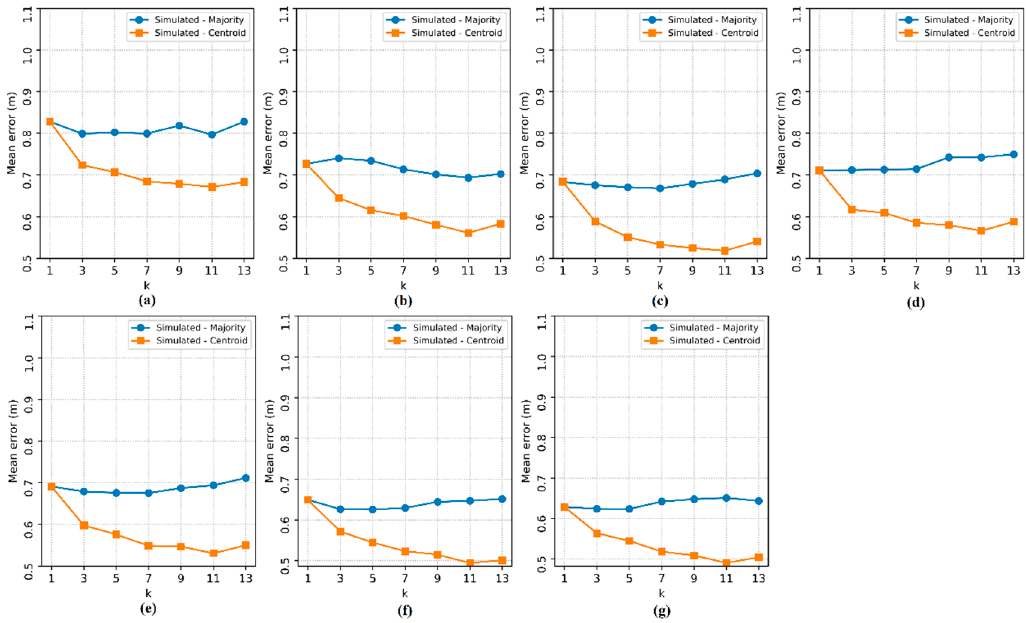
Figure 11. Localization mean error in the simulated environment with an area of 7 m × 7 m. The subfigures show the tests for each number of access points: ( a ) 2 APs, ( b ) 3 APs, ( c ) 4 APs, ( d ) 5 APs, ( e ) 6 APs, ( f ) 7 APs and ( g ) 8 APs.